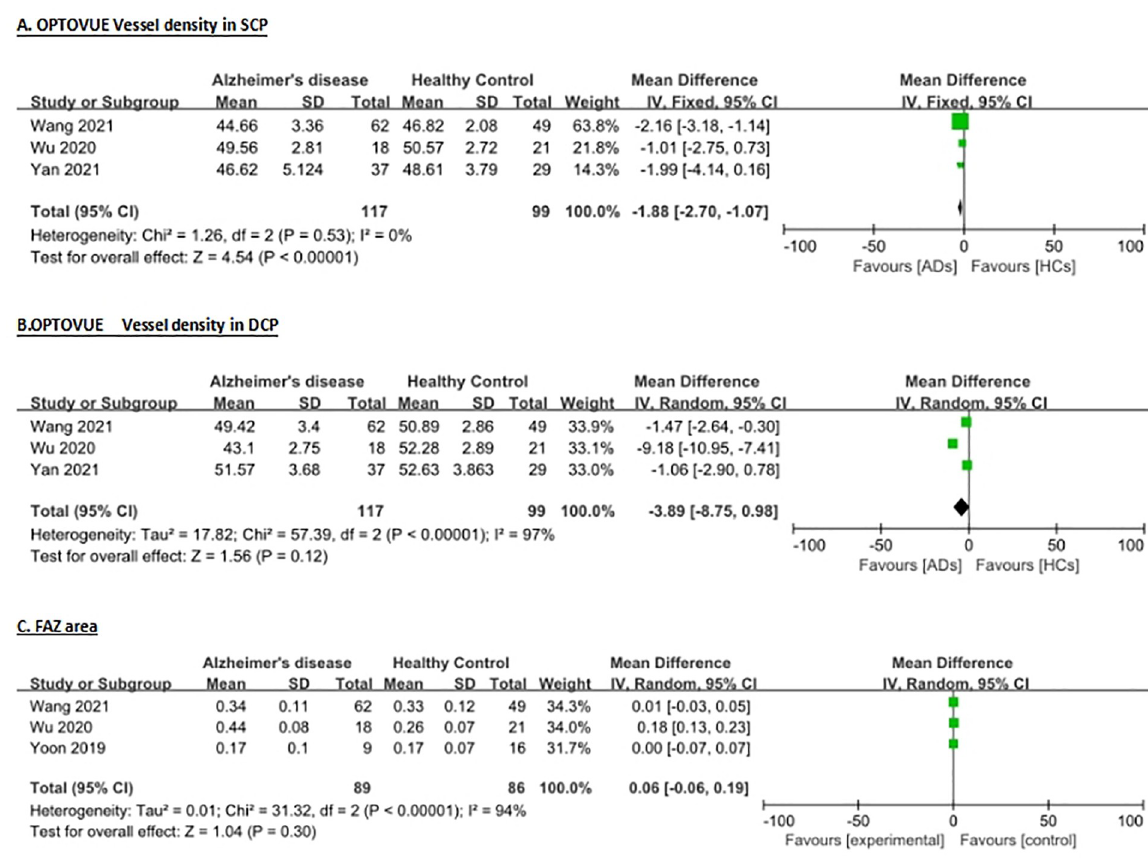
Fig 3. Meta-analysis of vessel density (VD) for Alzheimer’s disease patients versus healthy controls. Mean and standard deviation (SD) are included, with 95% confidence intervals (CIs), heterogeneity scores and overall effect in an inverse variance (IV) random effects model. The green square size represents the weight attributed to each study based on relative sample size. (A) VD in superficial capillary plexus (SCP) detected by Optovue. (B) VD in deep capillary plexus (DCP) detected by Optovue. (C) Area size of foveal avascular zone (FAZ) in mm2.